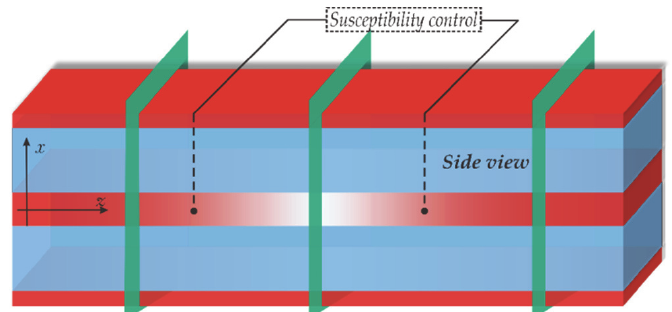
Figure 4. The schematic side view of the two coupled planar waveguides with additional control of the susceptibility in the middle part in a three-dimensional topology. Susceptibility of one of them is changed along the direction of the signal propagation.